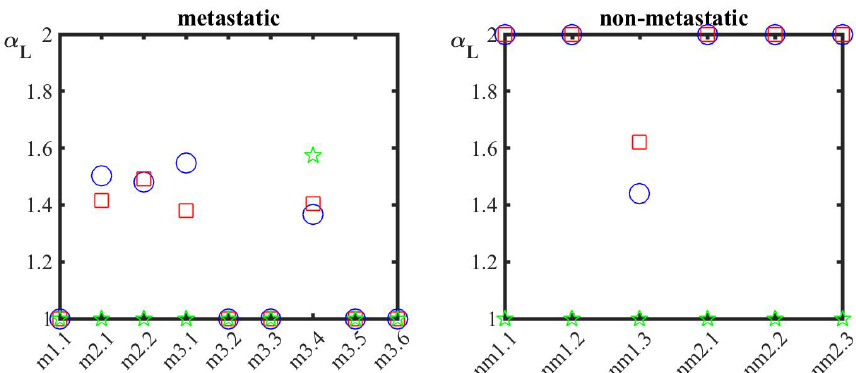
Figure 3. The multifractality index α L obtained by the best fitting of z ( q ) by means of equation (B.4) or special cases of it, for the surface, as well for separate analysis in x- and y- axes. Symbols: blue circles for height-height surface roughness, red squares for surface roughness along x-axis which is identified to the scanning one, and green star for y-axis.